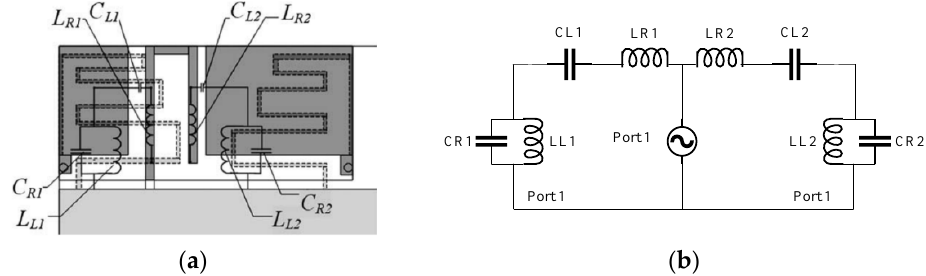
Figure 6. A compact multiband antenna employing dual-band CRLH TL for smart mobile phone application [53]. ( a ) The schematic diagram of the antenna with the circuit parameters. ( b ) The equivalent circuit of this antenna.